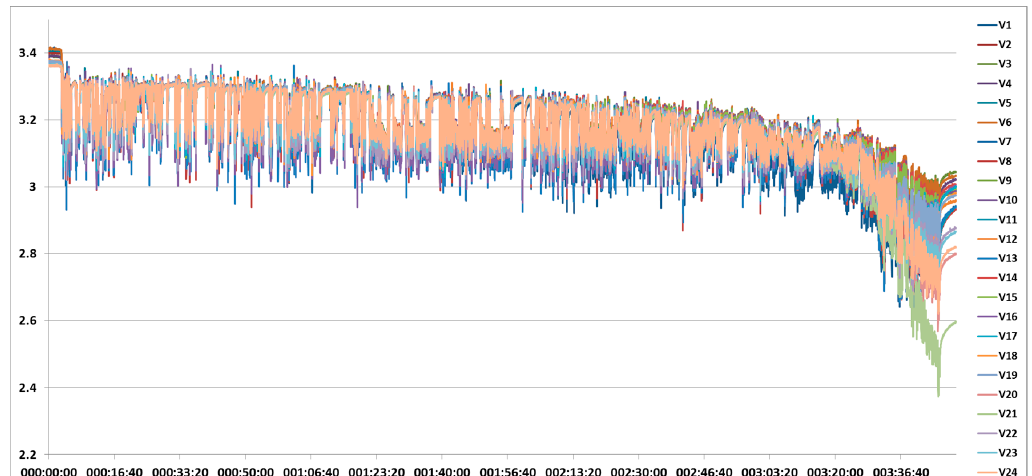
Figure 10. Discharging cell voltage histories.